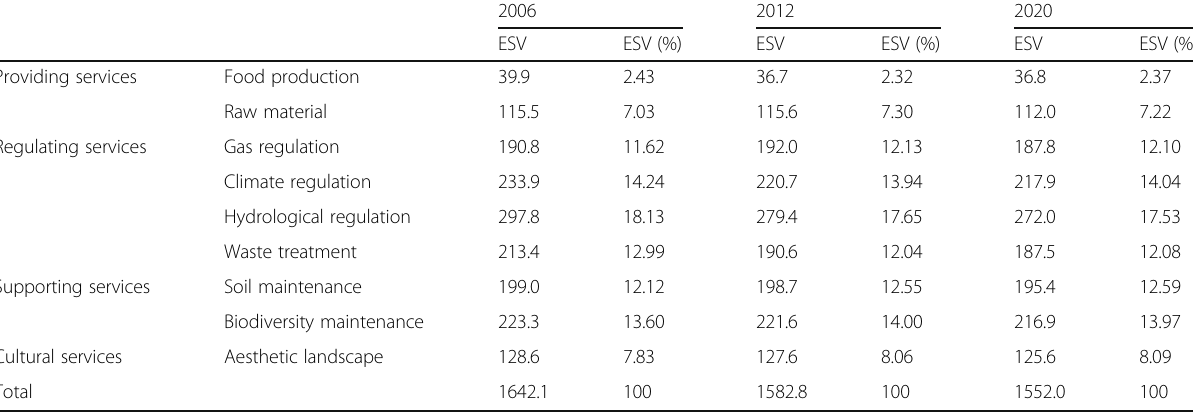
Table 8 Values of ecosystem service functions (unit; million Chinese